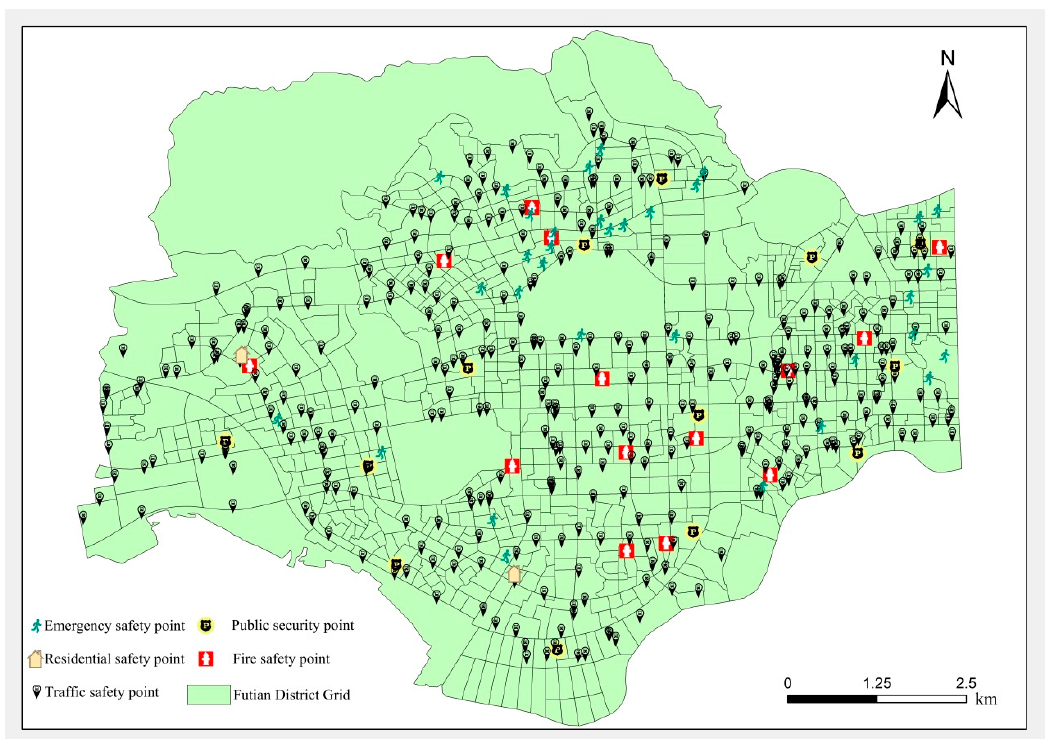
Figure 7. Infrastructure distribution.